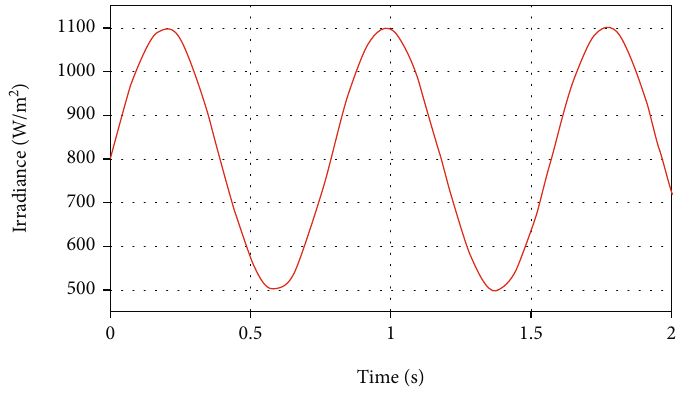
Figure 17: Sin irradiance pro fi